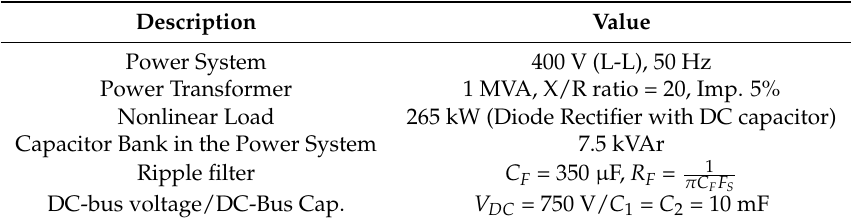
Table 4. Simulation